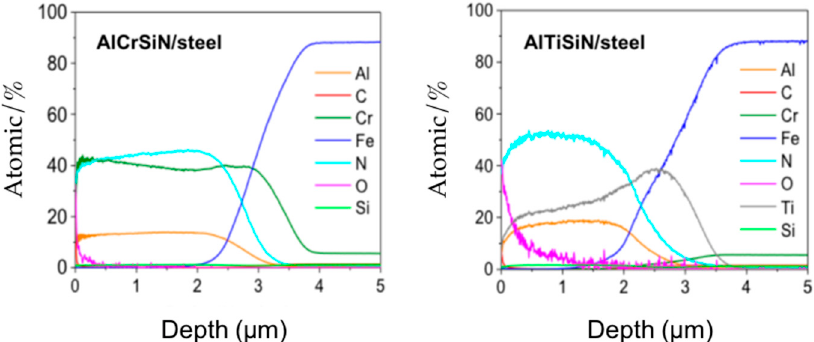
Table 4. Thickness of coated samples.